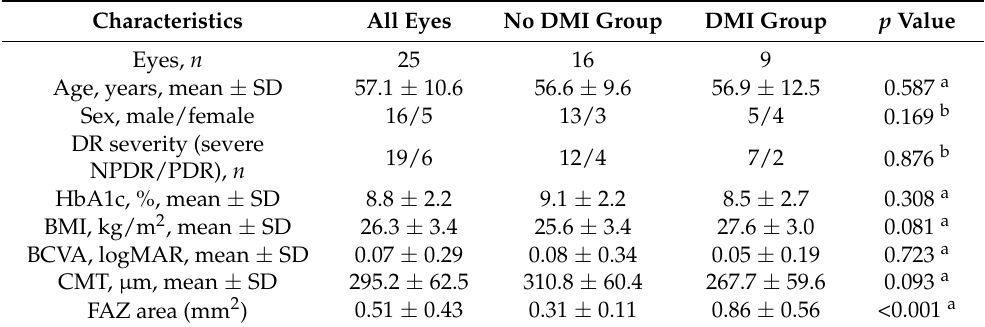
Table 1. Characteristics of the study group.